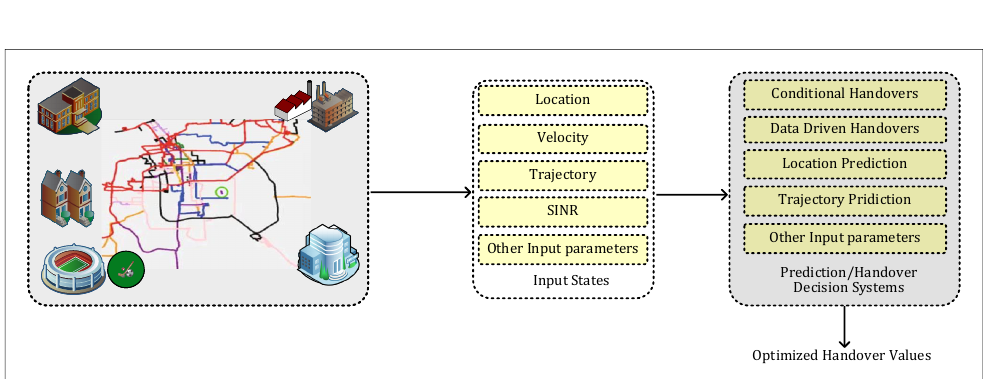
Figure 11. A Basic Illustration of Spatial Information-based Handovers in